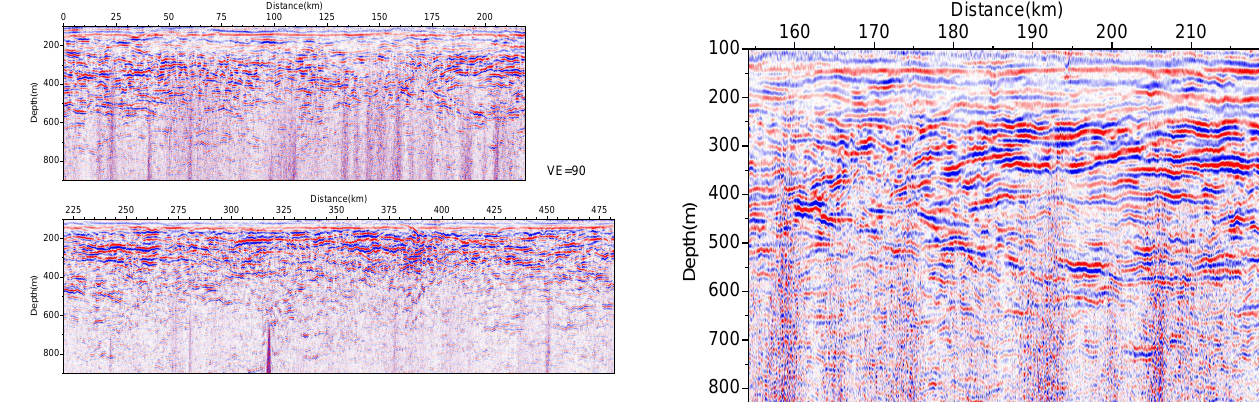
Fig. 2. Seismic images of the north (upper panel) and south (lower panel) subsections with vertical exaggeration (VE) of 90. The colour represents the relative reflection strength of the water col- umn.